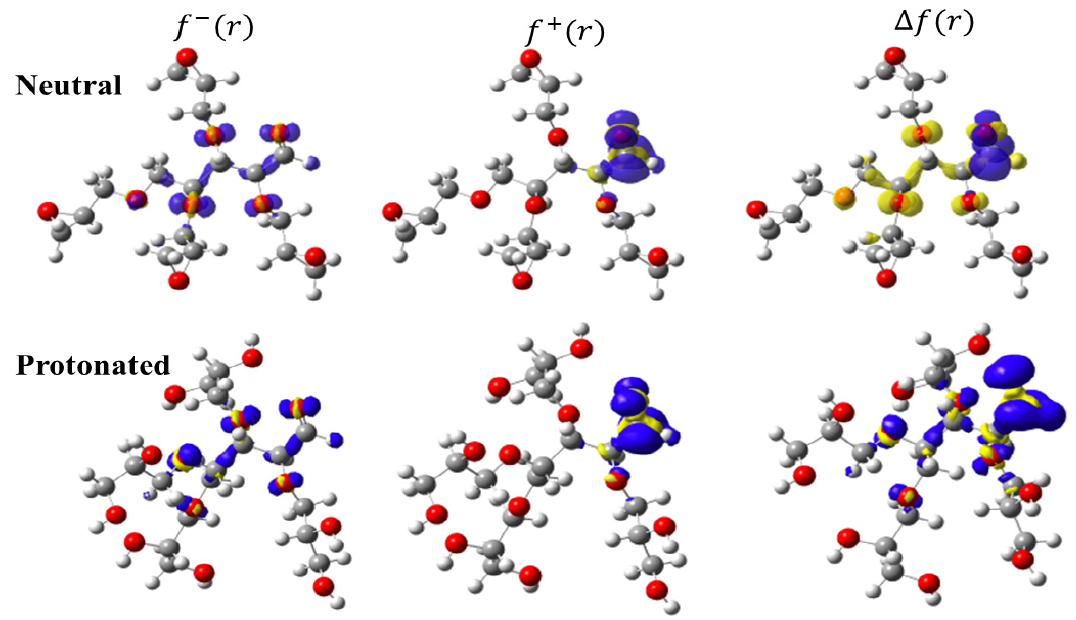
Figure 8. The 3D plots of the iso-surfaces of the electrophilic ( f − ( r ) ( left ), nucleophilic ( f + ( r ) ) ( middle ) and dual Fukui descriptor ( right ) of the TGP inhibitor, as found using the B3LYP/6- 31+G(d,p)/H 2 O/PCM model of theory. Blue and negative lobes correspond to positive and negative values, respectively.